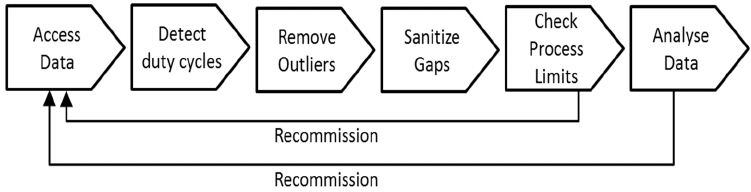
Figure 1. Data sanitation workflow.